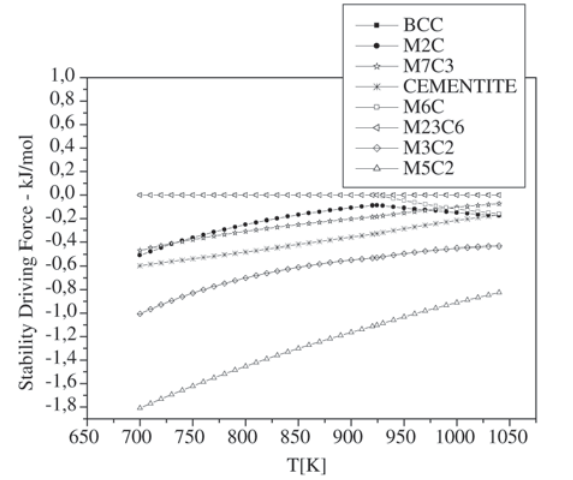
Figure 6. Theoretical content of the metals Fe, Cr and Mo in the C metal sublattice of M 23 6